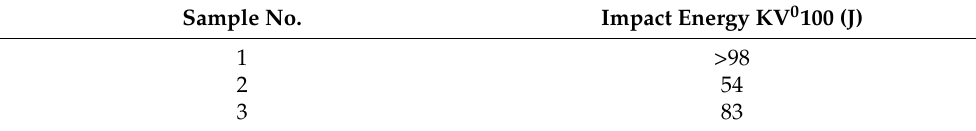
Table 5. Results of the impact strength test of samples from the handy-size bulk carrier 30206 DWT. Sample